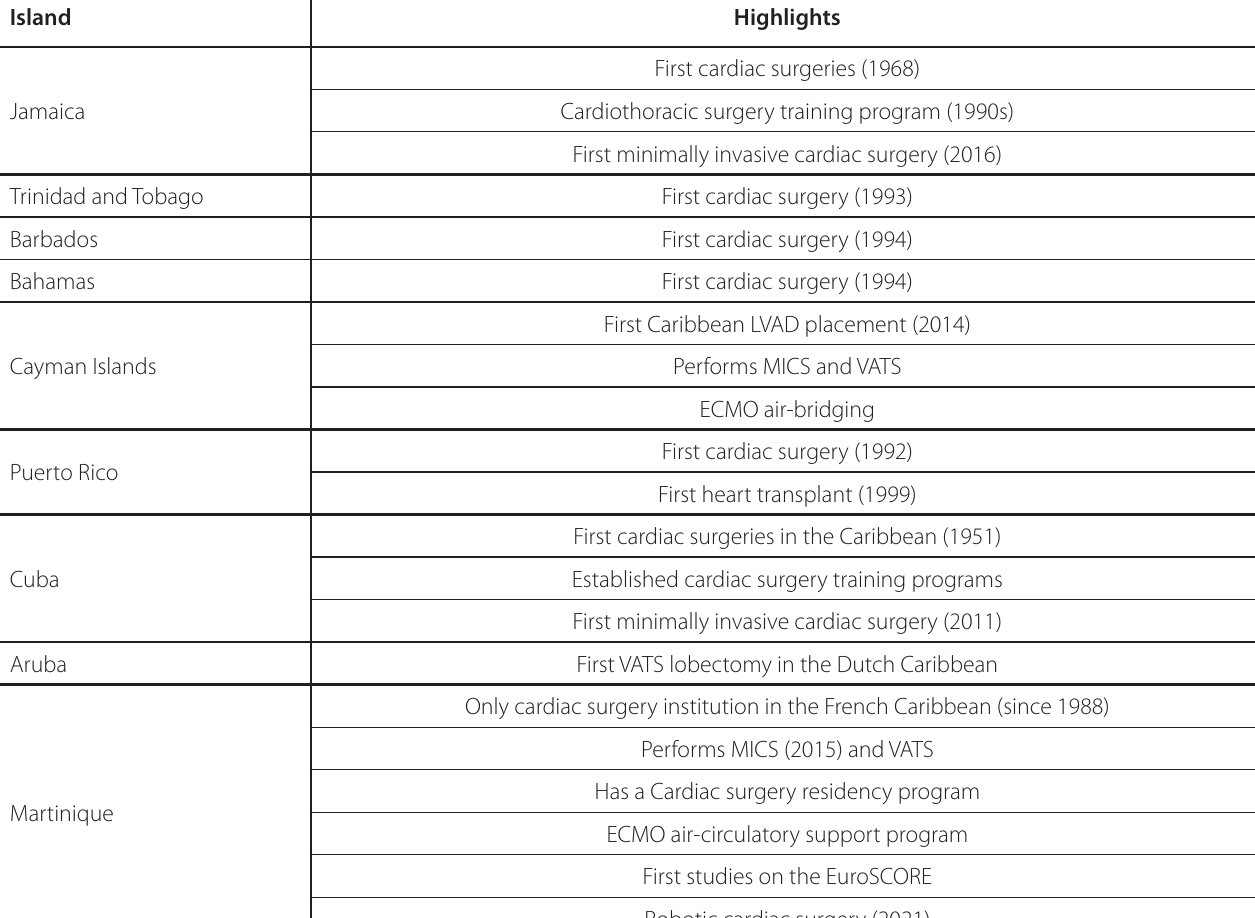
Table 1 . Caribbean cardiac and thoracic surgery